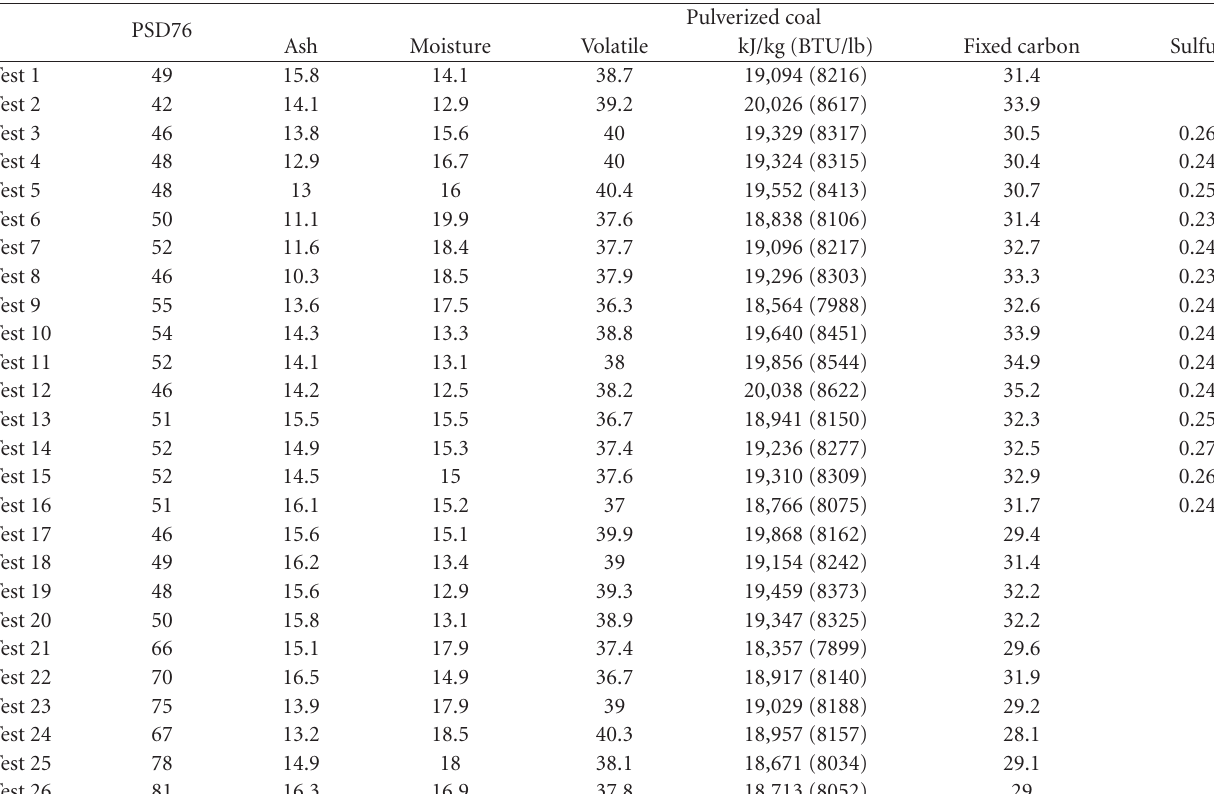
Table 2: Data on pulverized coal (as